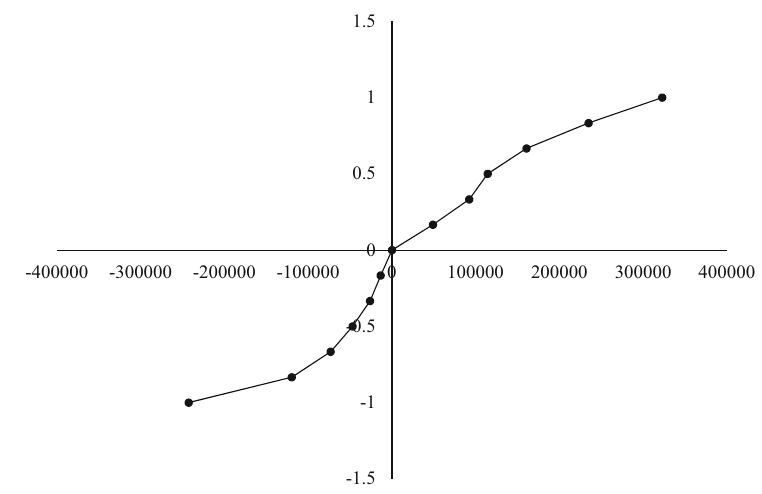
Fig. 5 Value function over all subjects’ average elicited